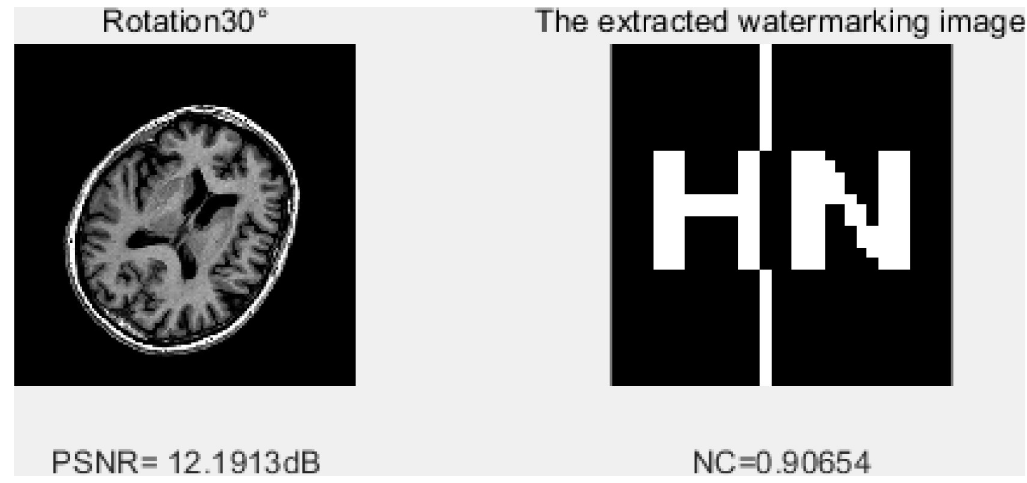
Fig 13. The 100% correlation accuracy indicates that the proposed algorithm performance in clipping attacks is best.